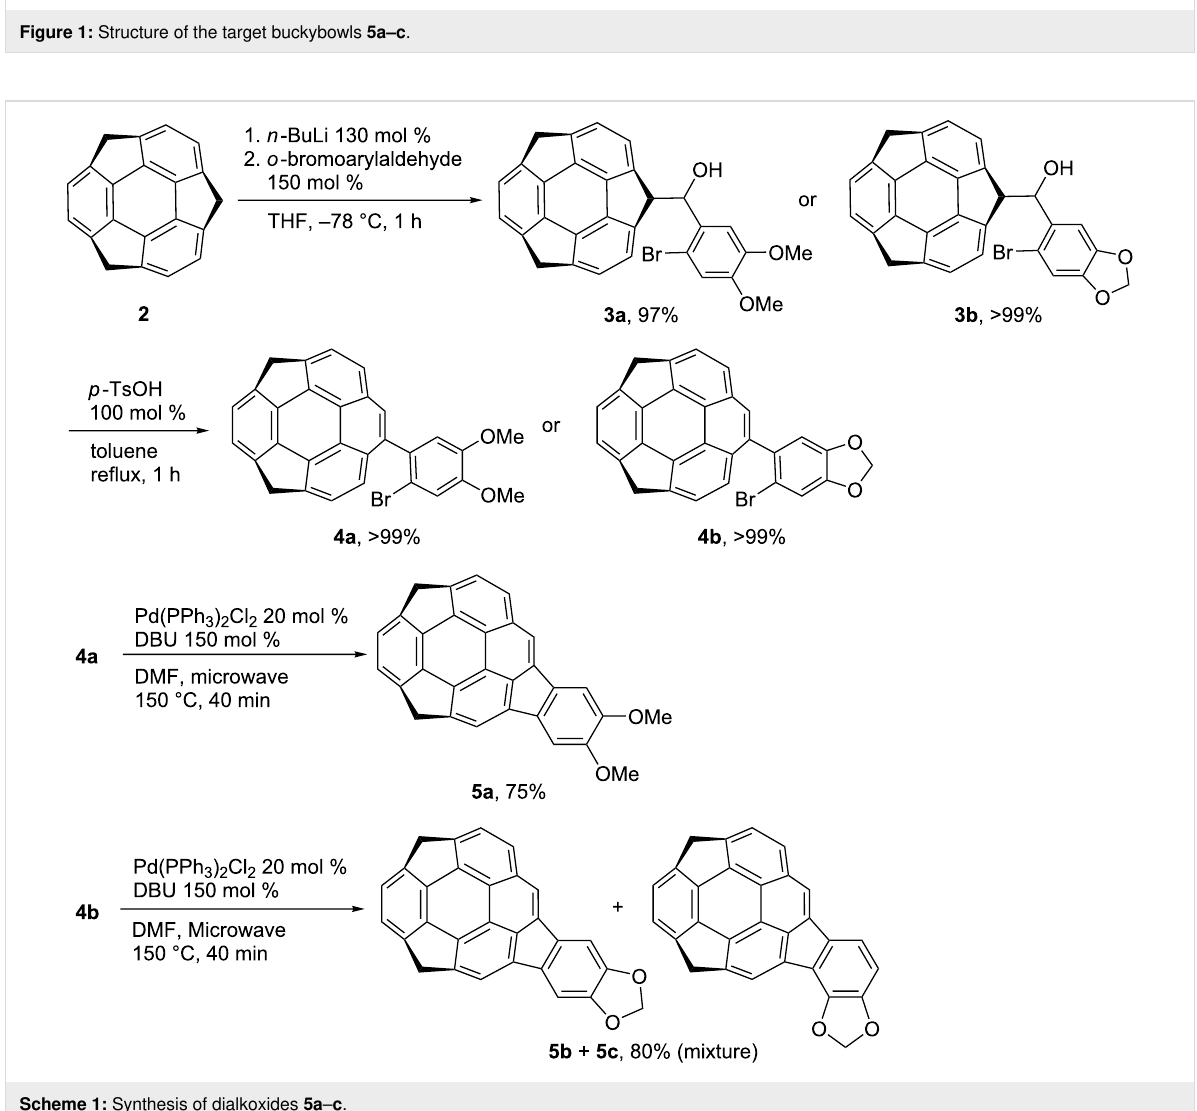
Scheme 1: Synthesis of dialkoxides 5a – c